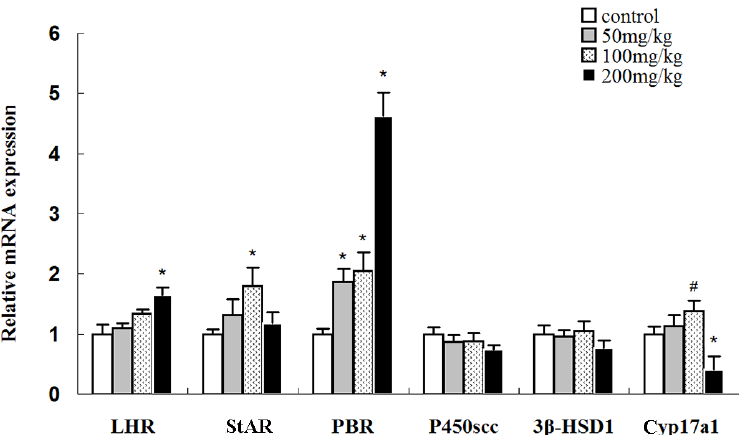
Figure 6. Expressions of LHR, P450SCC, Cyp17a1, PBR, StAR, and 3 β -HSD1 mRNA in the testes of rats treated with different doses of icariin. The mRNA levels were normalized to β -actin mRNA. The mRNA levels of the control group were set as 1. Values are the mean ± SD of 10 rats. # p < 0.05, * p < 0.01 vs. control